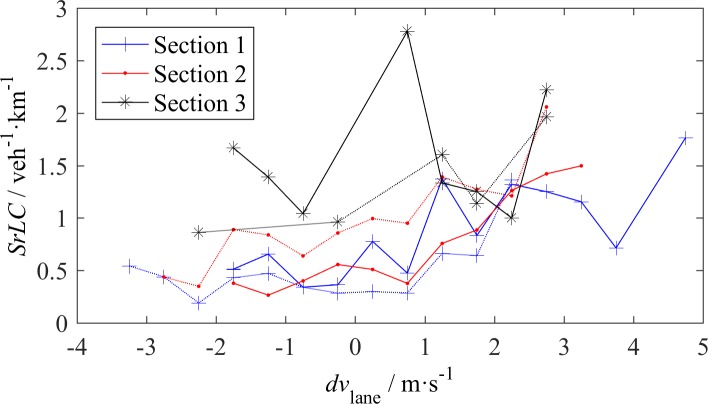
LC rate–speed difference across the lanes (dvlane) relationship, the solid lines represent SrLCL and the dash lines represent SrLCR.